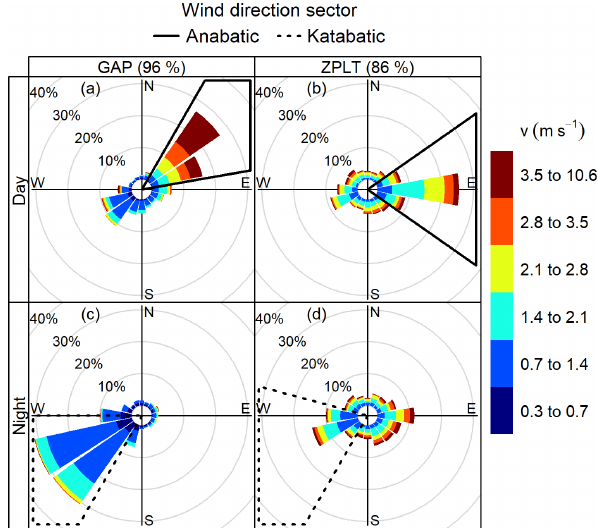
Figure 4. Wind rose plots showing the frequency of counts by wind direction and velocity ( v ) at the GAP (a, c) and ZPLT (b, d) sites during day- (a, b) and nighttime (c, d) in summer (June to August). Daytime was defined by a global radiation of > 5Wm − 2 at a min- imum of one of the sites used in this study; all other cases were treated as nighttime. The plots were used to define wind direction sectors for thermally induced anabatic and katabatic winds. The per- centage in brackets specifies the data